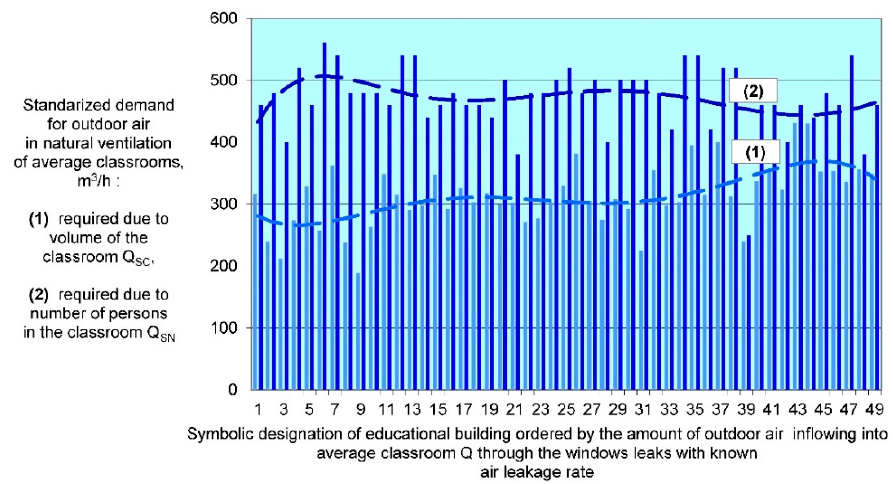
Figure 8. Standardized demand for outdoor air in natural ventilation of average classrooms in the analysed education